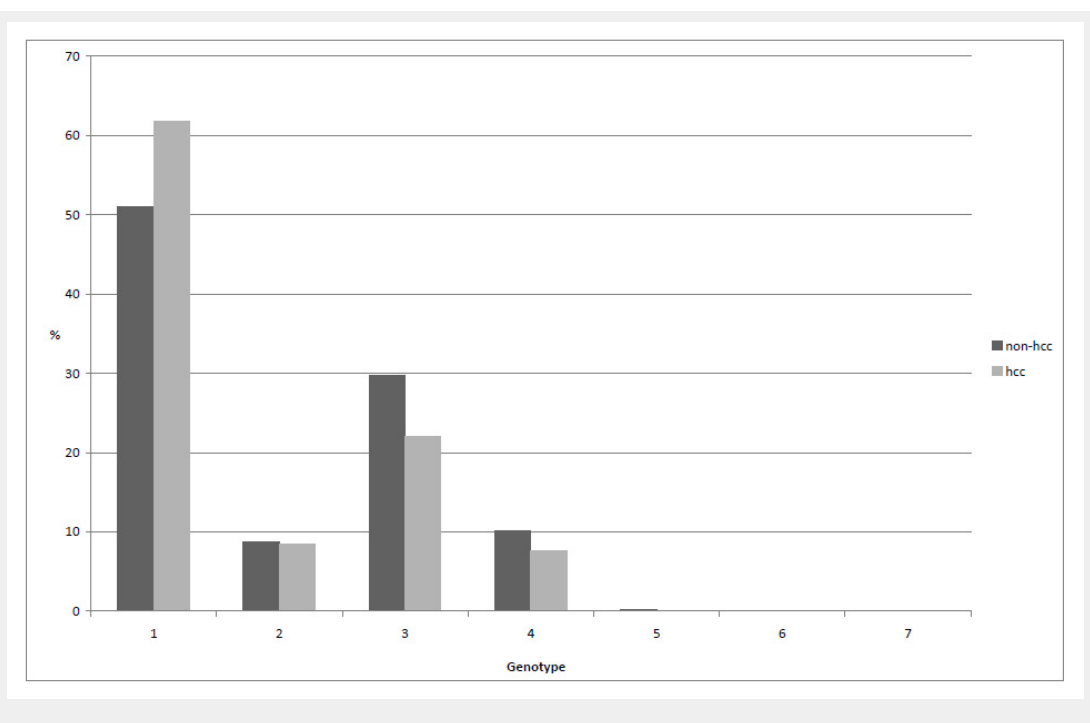
Figure 3 Frequency hepatitis C virus genotypes, compared between HCC and non-HCC group.